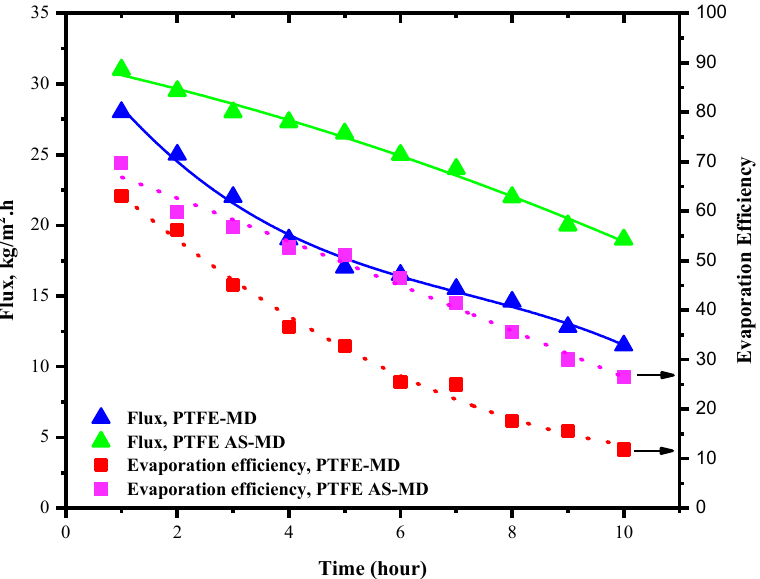
Figure 4. Flux and evaporation efficiency of PTFE control membrane. Feed HA concentration: 100 mg/L, temperature 60 °C, feed flow rate 75 mL/min.